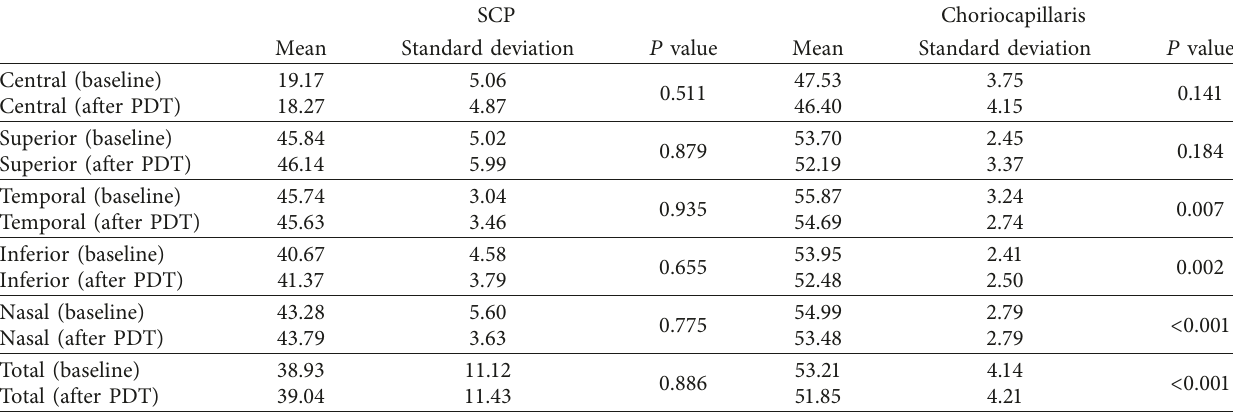
Table 3: Mean vessel density of the quadrants at the SCP and choriocapillaris before and three months after PDT treatment.